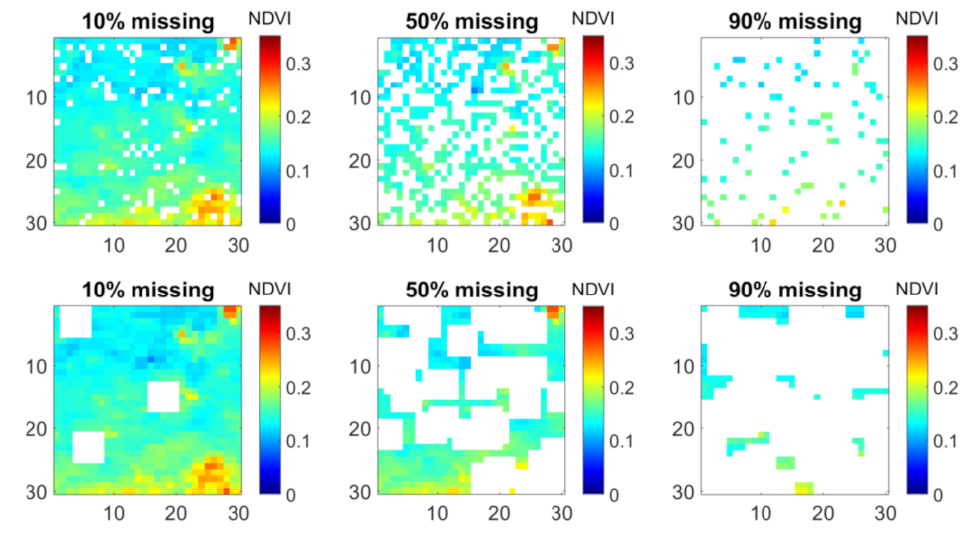
Figure 5. Three different levels of missing data for one frame in SIM1 are displayed as examples. Upper row indicates data missing completely at random (MCAR). Lower row indicates data missing at random